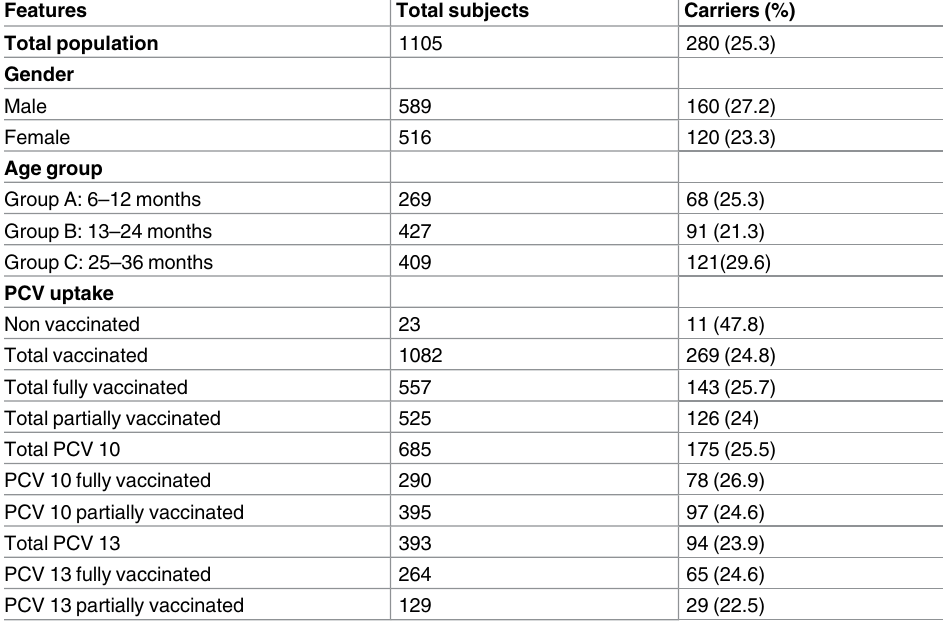
Table 1. Pneumococcal NP carriage rate according to demographics and vaccination